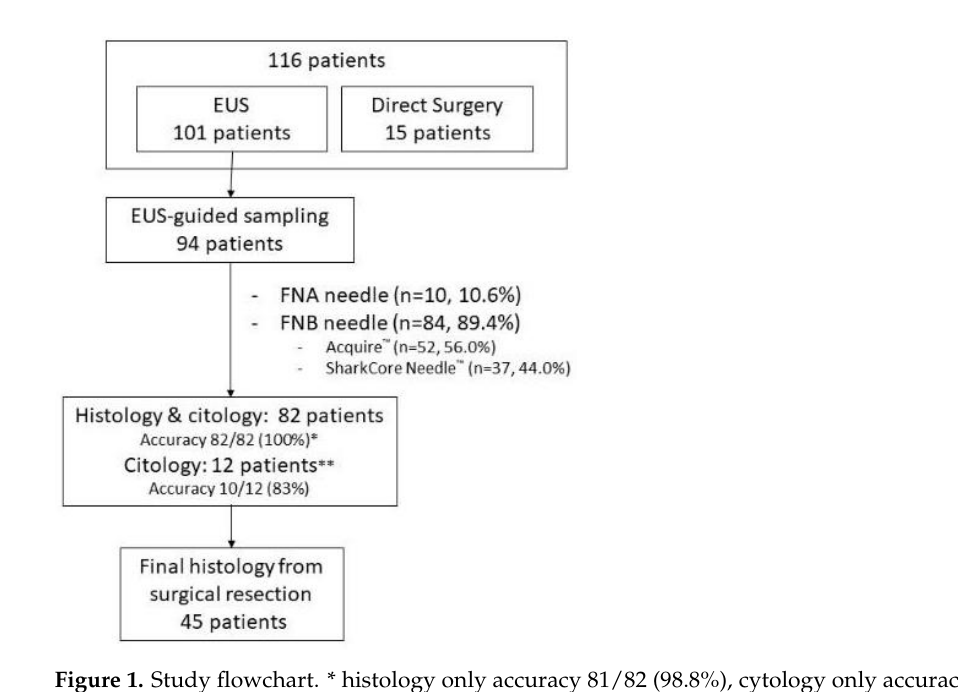
Table 1. Baseline characteristics. * 79 lesions >20 mm, 110 lesions 10–20 mm, 47 lesions <10 mm.